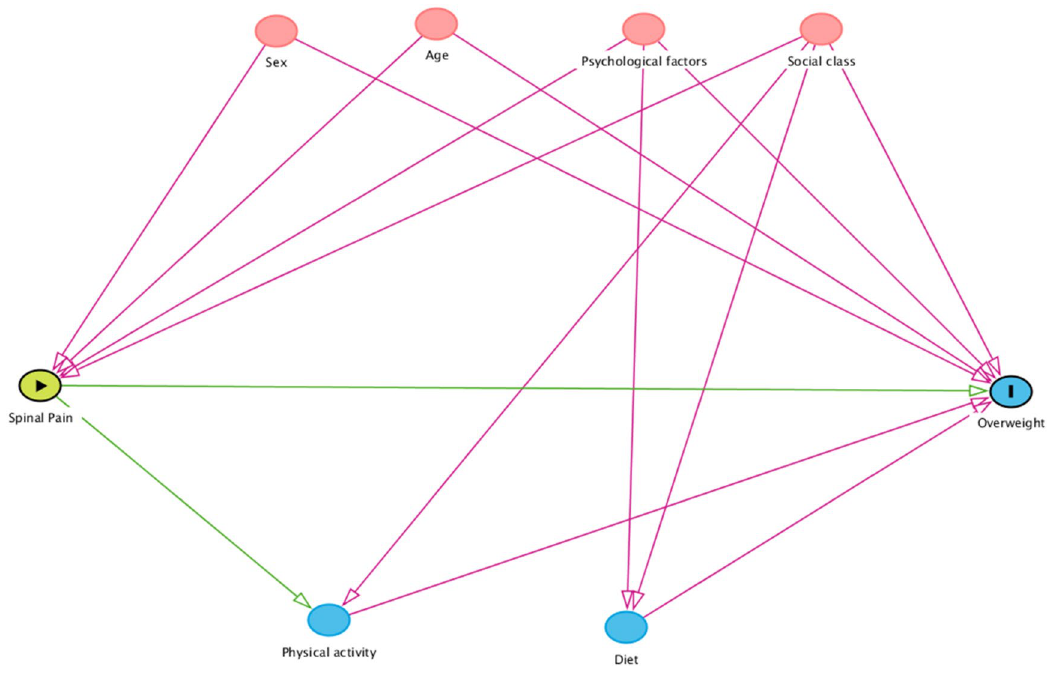
Figure 1. Directed acyclic